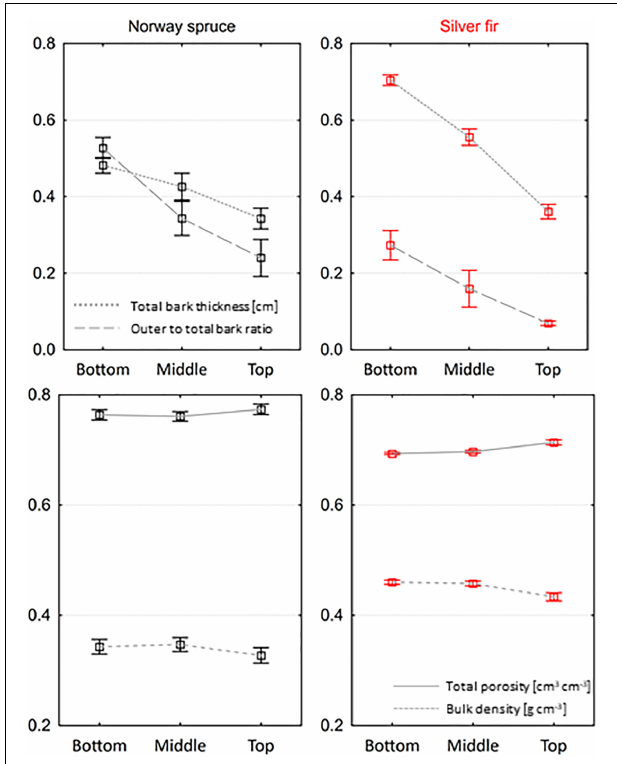
FIGURE 5 | Variation in bark physical properties along stems of Norway spruce and silver fir trees (mean ± SE).